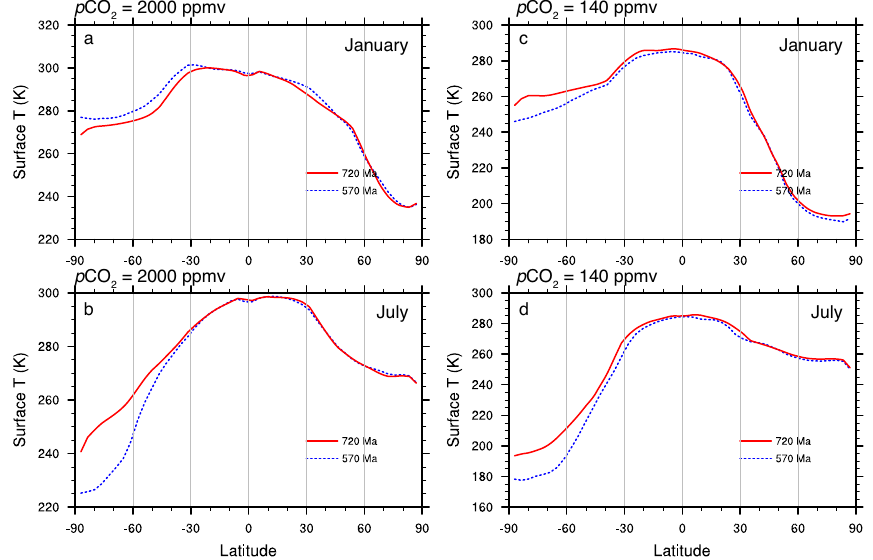
Fig. 8. Zonal mean surface temperature for the last 100 yr of the control run (a) and (b) and branch run (c) and (d) . TSI = 0.94TSI 0 and τ = 0 . 12 for all the simulations. The upper and lower two panels are for January and July, respectively.